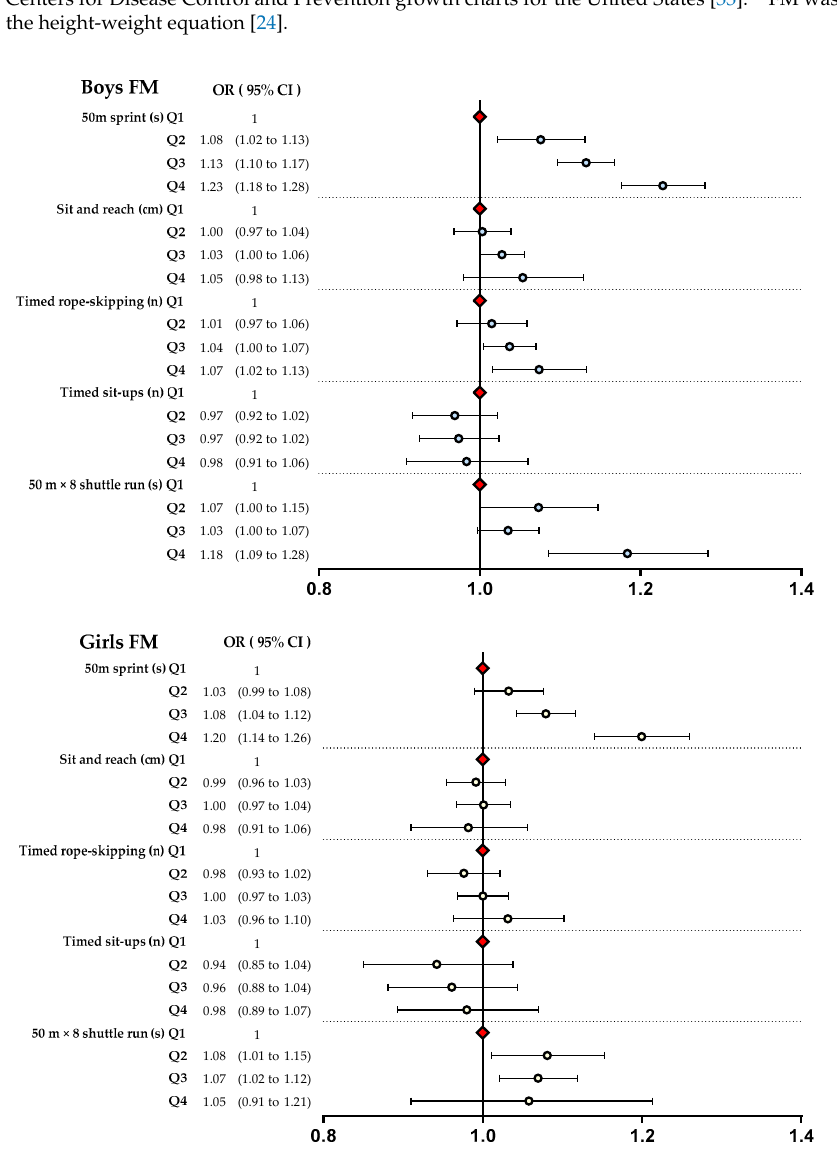
Figure 1. Logistic regression of the association between FM and health-related physical fitness in Chinese schoolchildren. Q1: 90.0 points or higher, Q2: 80.0–89.9, Q3: 60.0–79.9, Q4: <60. FM, fat mass.